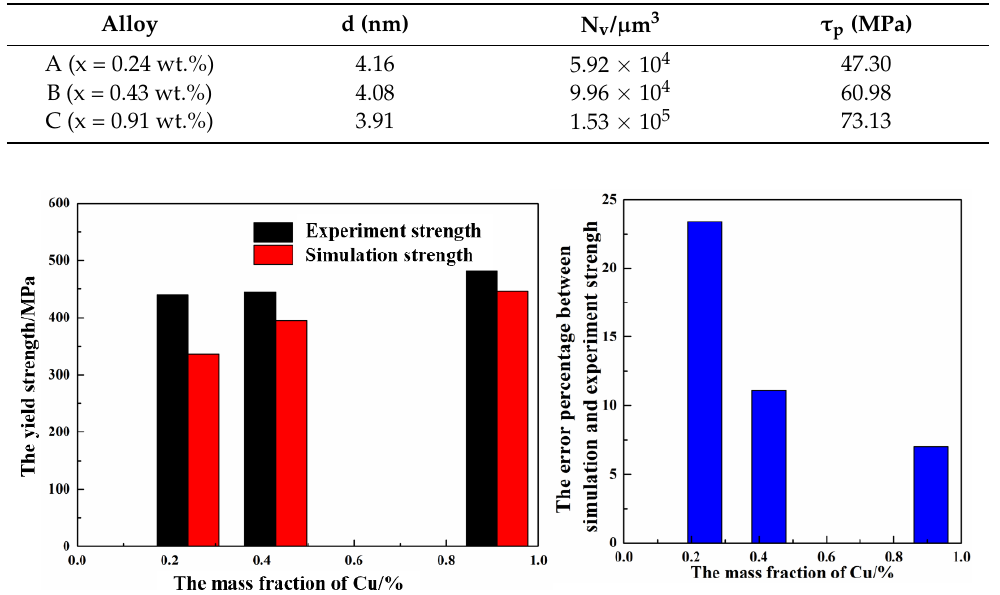
Figure 9. The ( a ) experimental yield strength and simulation yield strength of Al-5Zn-2.6Mg-xCu alloy and ( b ) error percentage between the simulation and the experimental results.